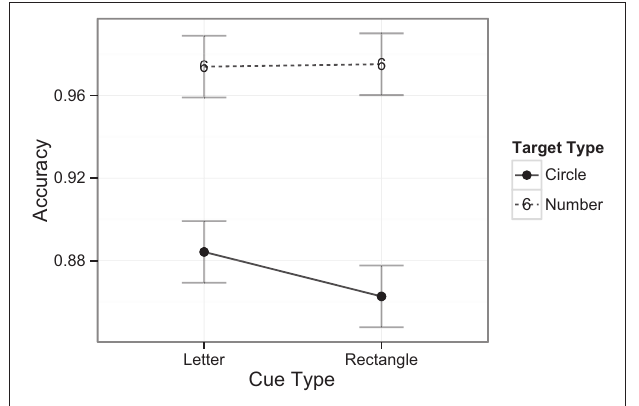
FIGURE 12 | Cuing effects within the spatial target detection condition.